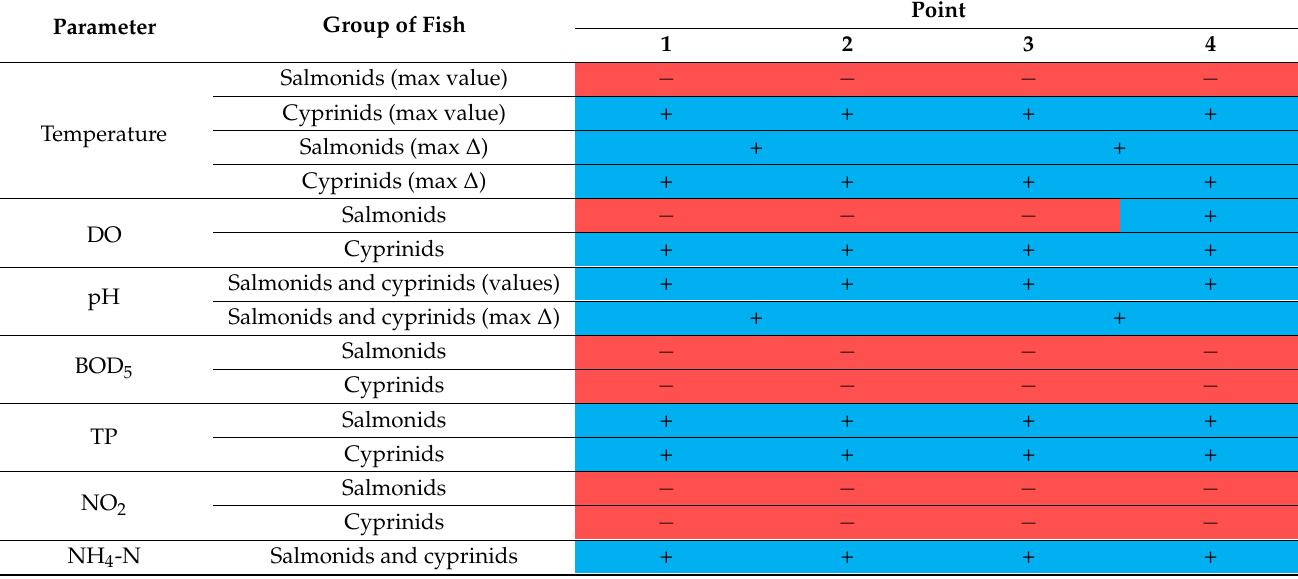
Table 13. List of results in the analyzed test points concerning fulfilling the conditions for